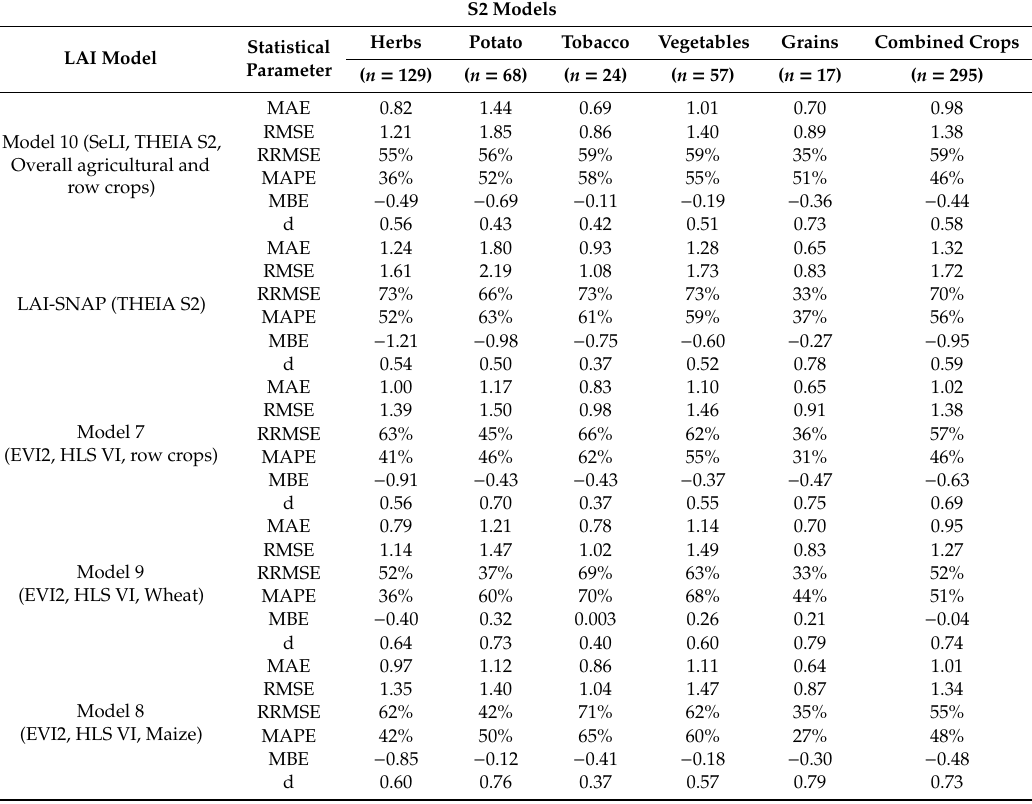
Table 5. Statistical analysis summary for the studied crops in both 2018 and 2019 growing seasons for the HLS VI best-performing models derived from S30, Model 10 (SeLI, overall crops) and SNAP model derived from S2 THEIA products.